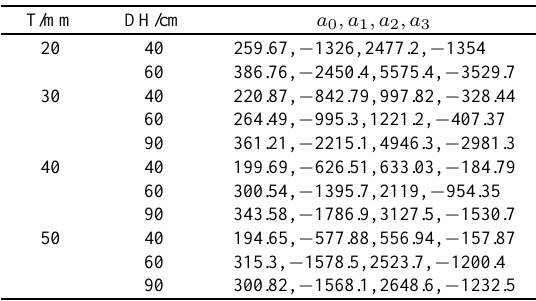
Fig. 3. Shock acceleration-time curve of honeycomb paperboard ( T = 40 mm, DH = 60 cm). Table 1 Characteristic coefficients of dynamic cushion curves of the